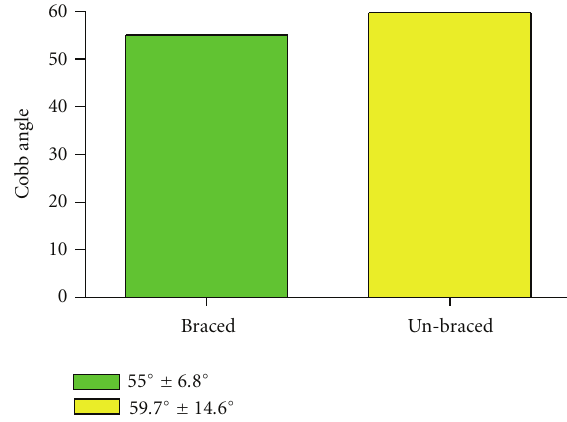
Figure 2: Two girls with right thoracic scoliosisof similarapex level. Digital photo (left) and surface topography (right) of the back. The surface topography image is presented in pseudo-Moire form for convenience.